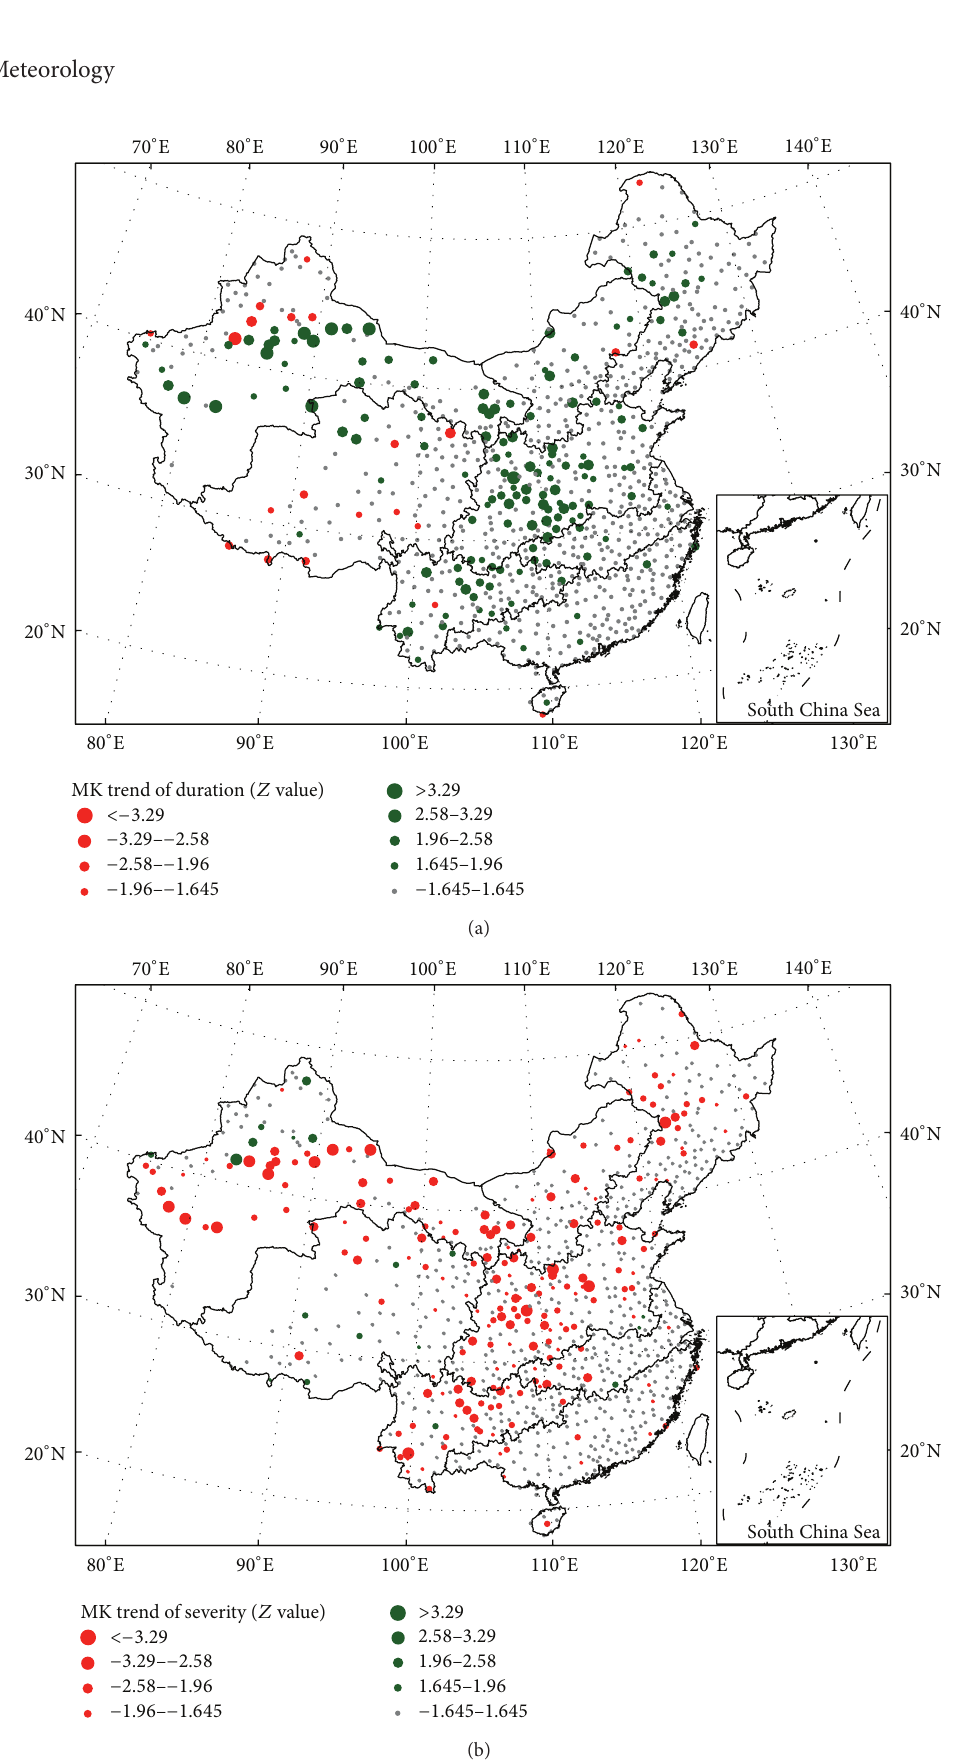
Figure 7: Trend variation of drought characteristics over China: (a) drought duration; (b) drought